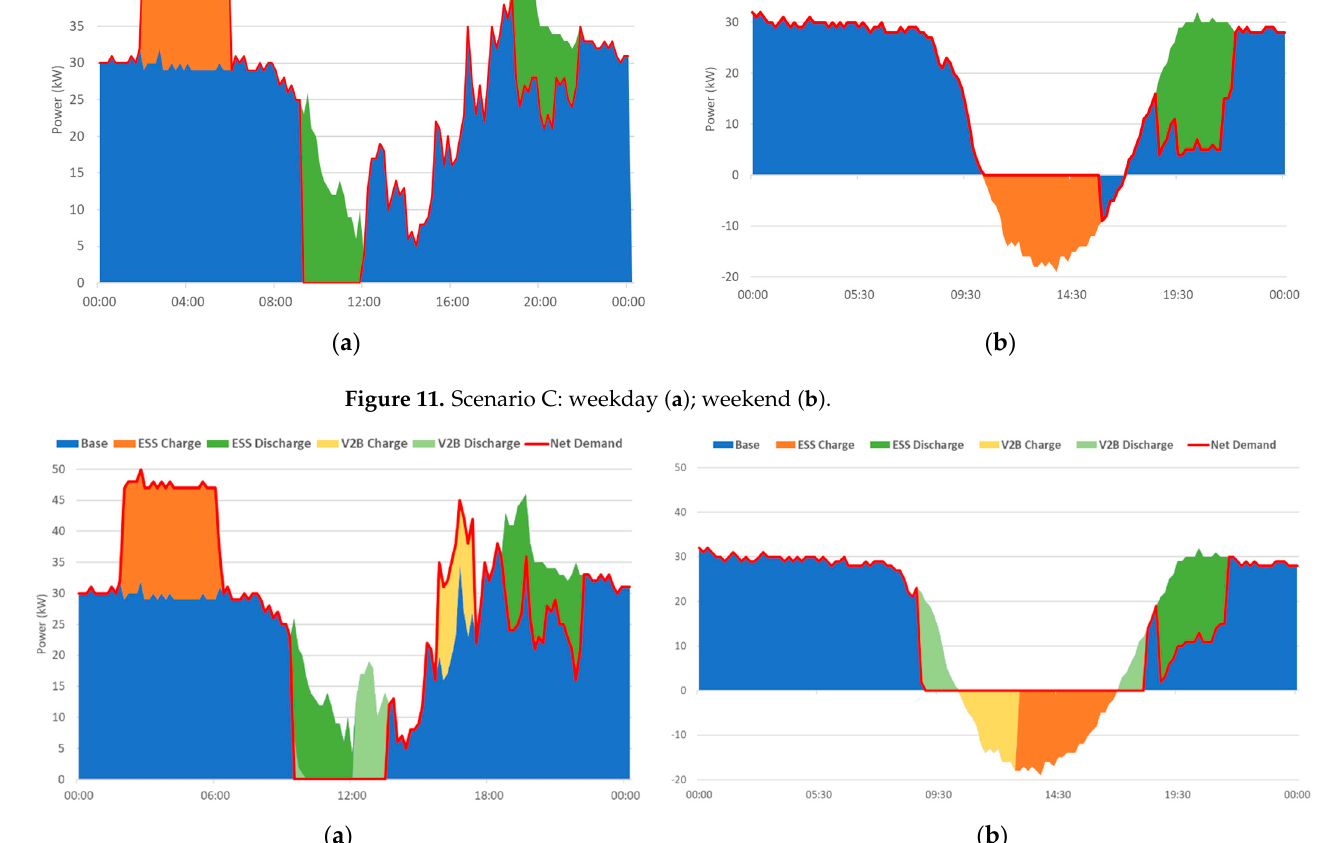
Figure 12. Scenario D: weekday ( a ); weekend ( b ).